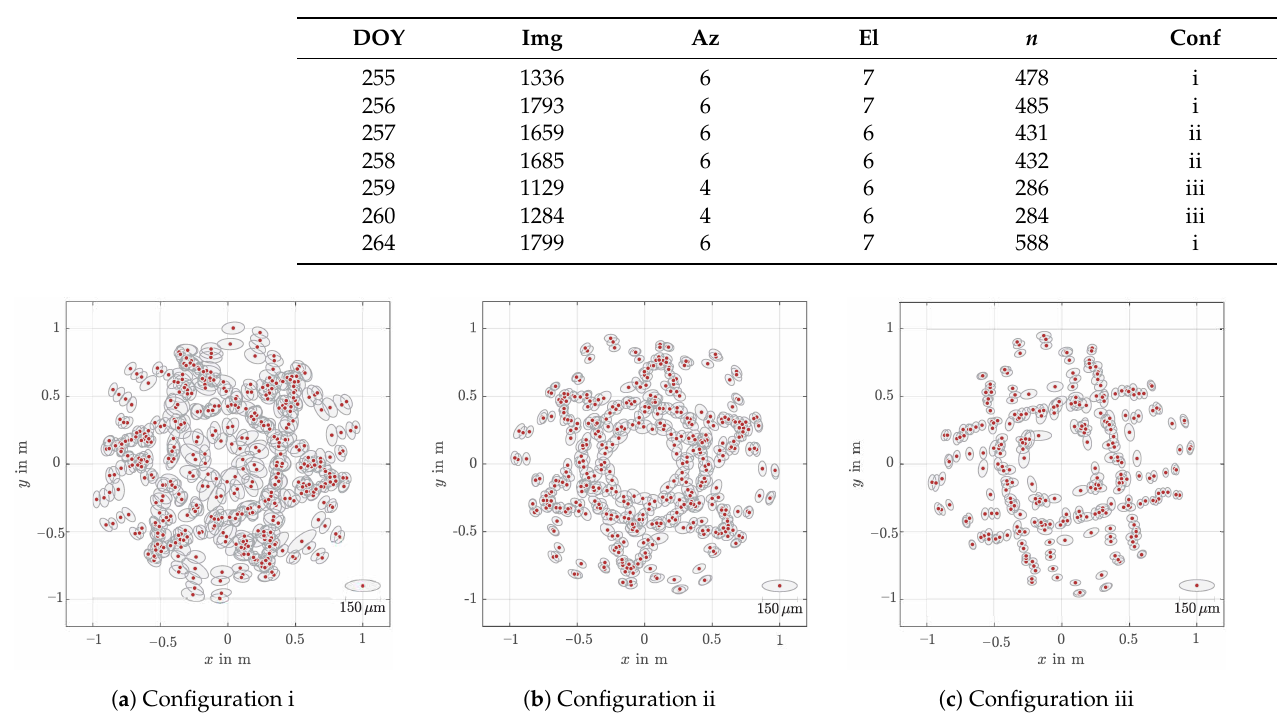
Figure 6. Horizontal distribution of the resulting point clouds for the three measurement configurations having: ( a ) six azimuths, seven elevations (i); ( b ) six azimuths, six elevations (ii); and ( c ) four azimuths, six elevations (iii). Grey ellipses depict the 1 σ confidences derived by the fully populated dispersion of the bundle